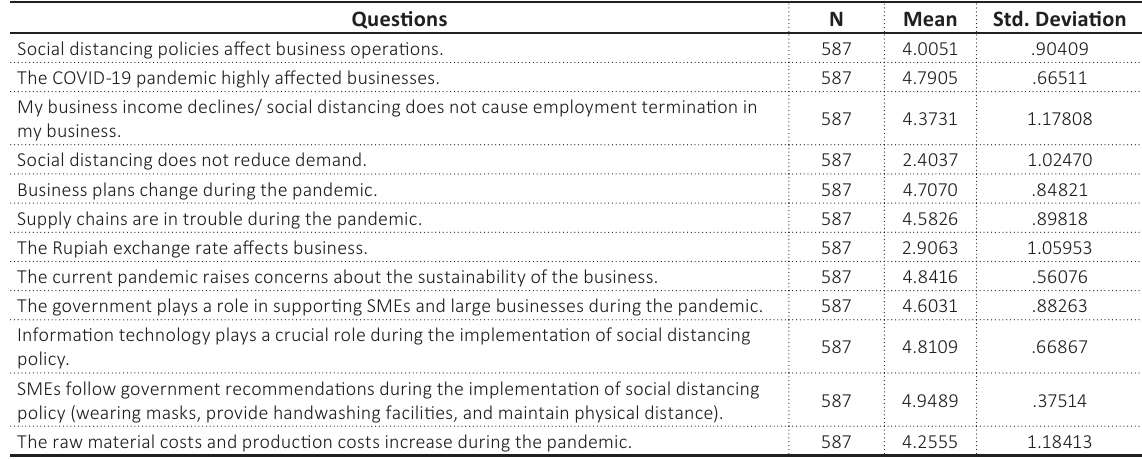
Table 1. Descriptive